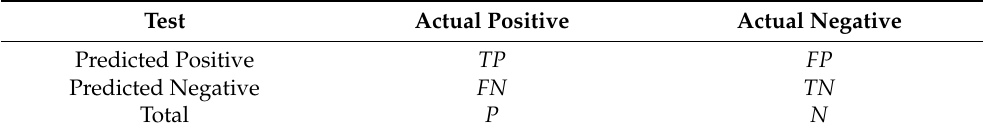
Table 2. Confusion matrix.